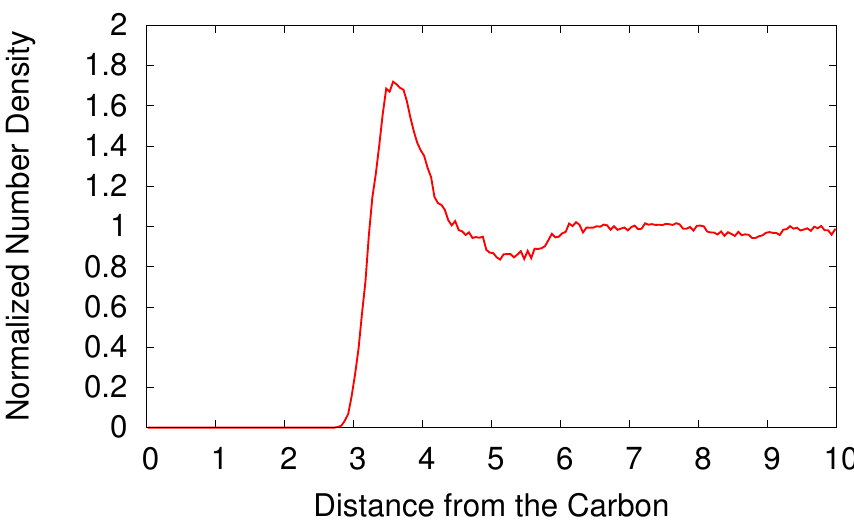
Figure 3. The normalized number density of H carbon atom of a CH OH in Å. The number density of H 3 number density of H O 2